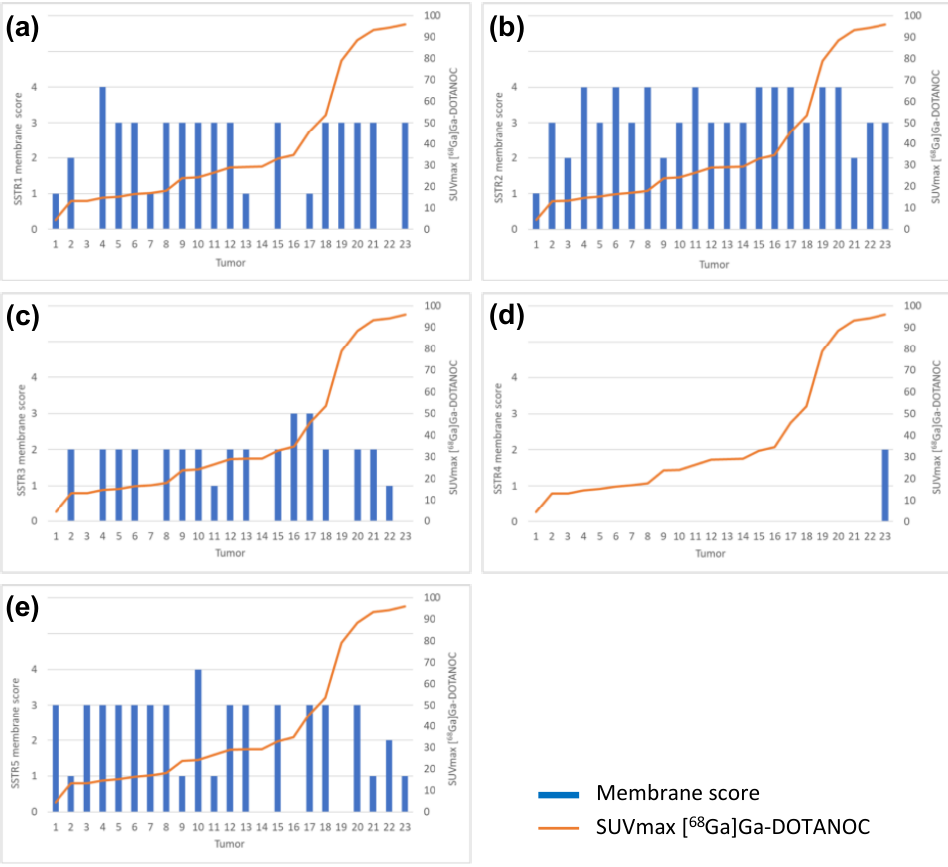
Figure 5. Immunohistochemical ( a ) SSTR1, ( b ) SSTR2, ( c ) SSTR3, ( d ) SSTR4 and ( e ) SSTR5 membrane expression profiles versus [ 68 Ga]Ga-DOTANOC uptake by all tumors analyzed ( n = 23).